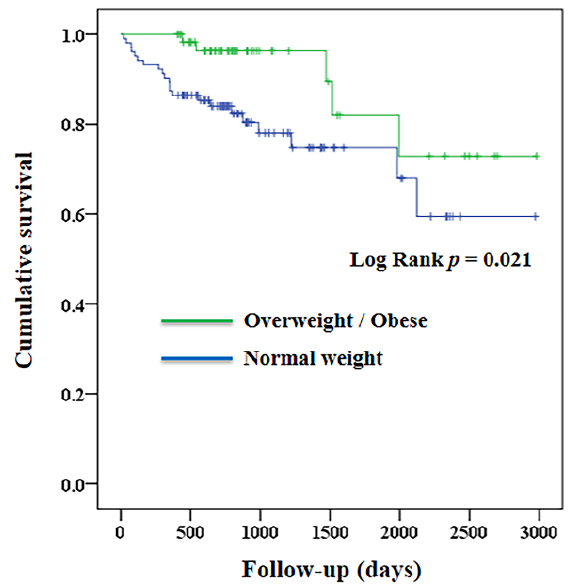
Figure 1. Survivalcurvesofthestudypatientswhowereoverweight/obese(bodymassindex ≥ 25kg/m 2 ) Figure 1. Survival curves of the study pa tients who were overweight/obese (body mass index ≥ 25 and normal weight (body mass index < 25 kg/m 2 kg/m 2 ) and normal weight (body mass index < 25 kg/m 2 ). Table 2. Associations of baseline characteristics with all-cause mortality of the study sample.